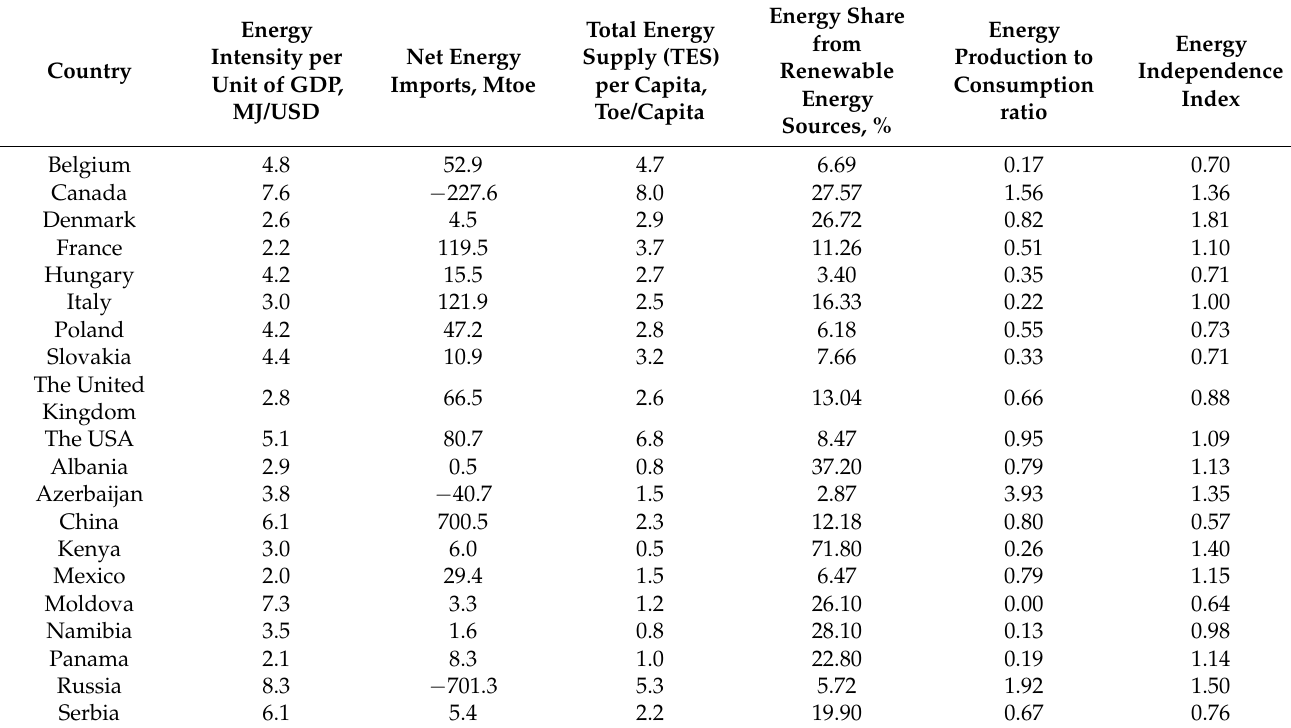
Table 2. Initial data for determining the level of energy independence of the studied countries.